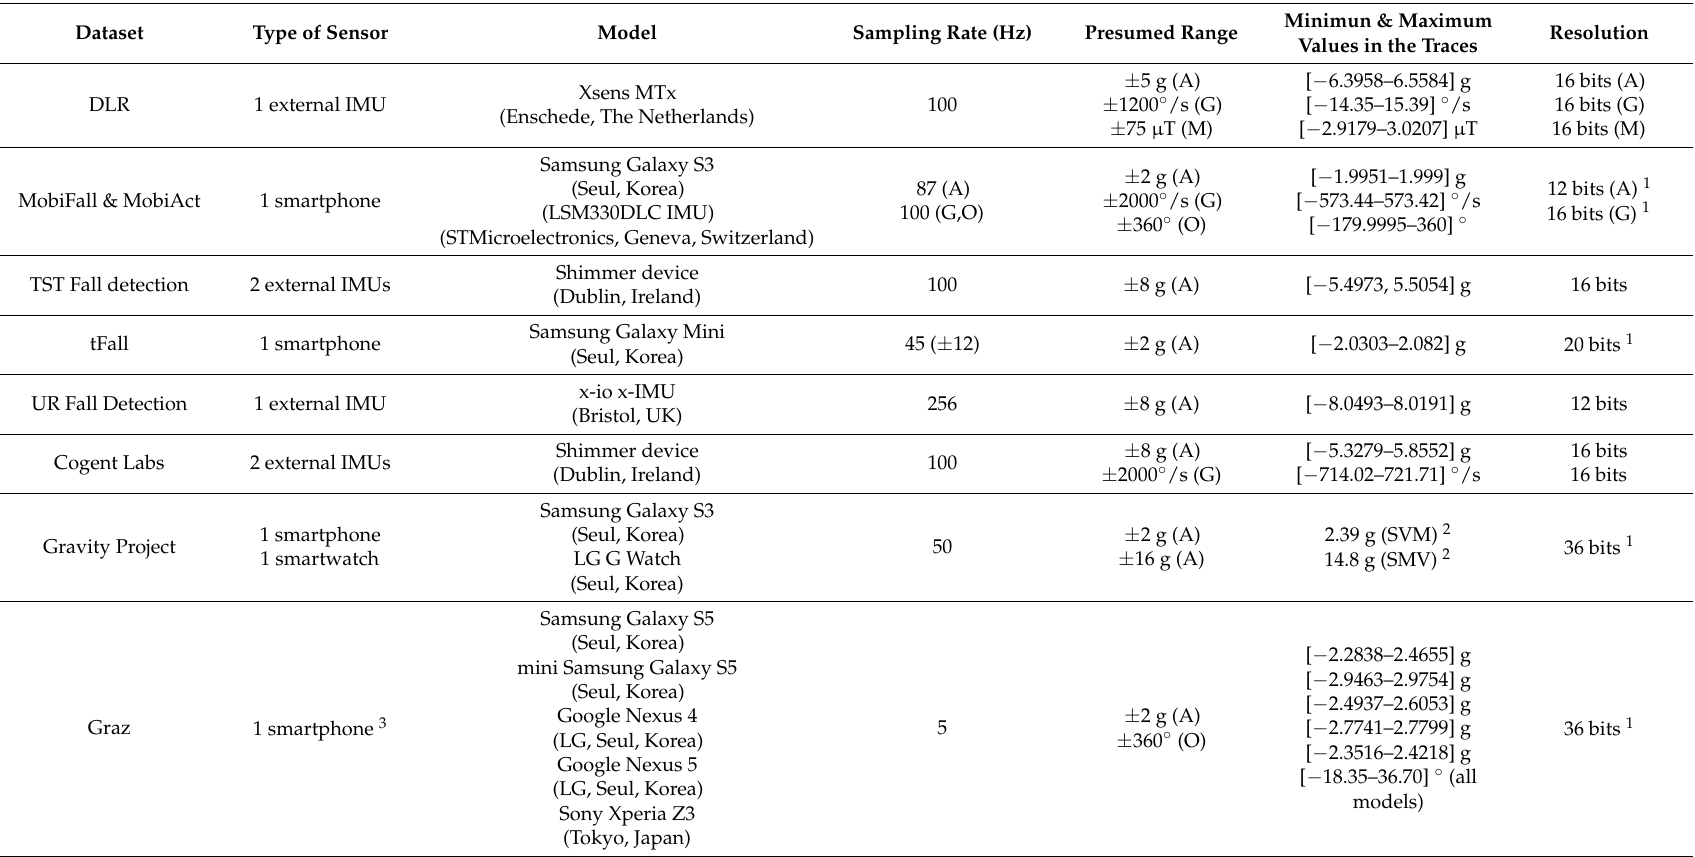
Table 8. Characteristics of the